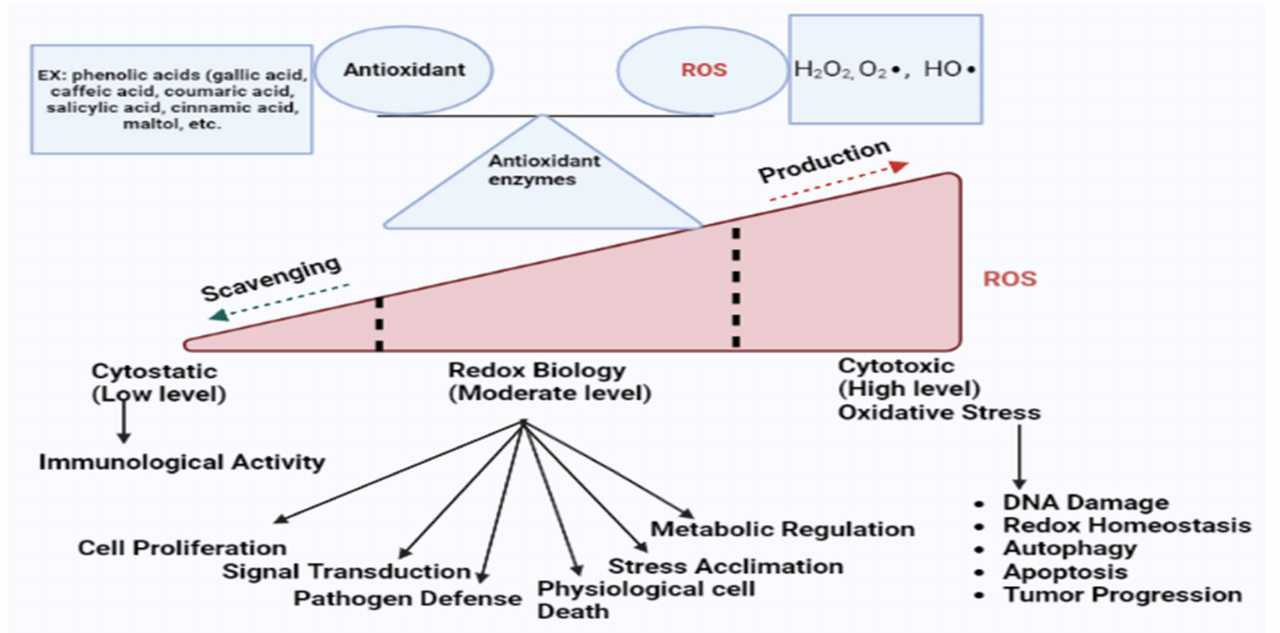
Figure 1. In normal cells, the balance between antioxidants and ROS remain at equilibrium due to the chemical reactions of antioxidant enzymes (SOD, CAT, GPx, and GST). However, the overpro- duction or scavenging of ROS breaks this equilibrium system. At the moderate or basal state, ROS perform as secondary messengers in several intracellular pathways that are essential for healthy cells. However, higher concentrations of ROS can cause oxidative stress, DNA damage, redox homeostasis, autophagy, apoptosis, tumor progression, and drug resistance which are related to the development of various